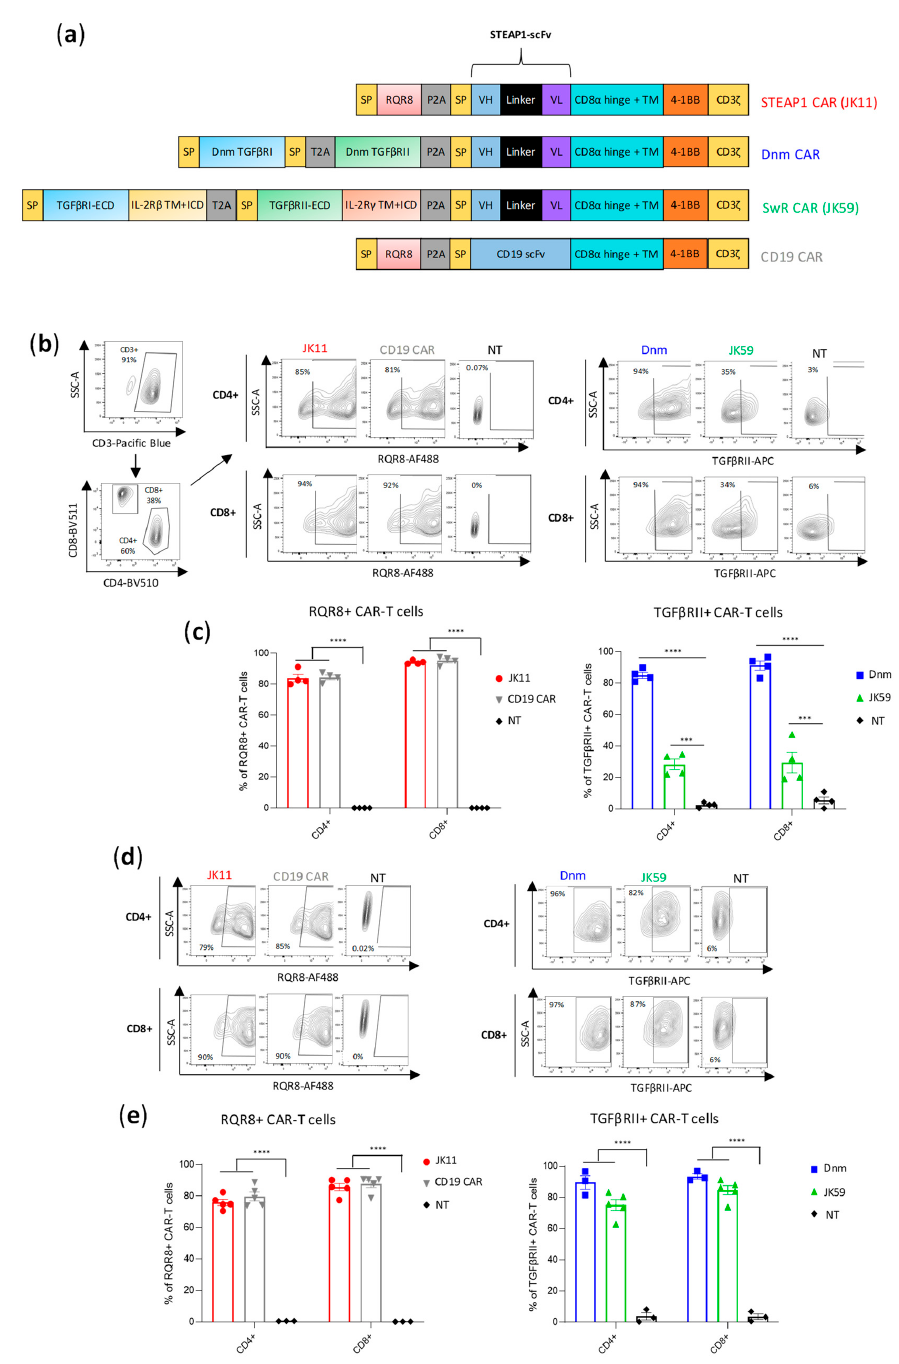
Figure 1. CAR design and expression. ( a ) Schematic representations of the CAR constructs; parental STEAP1 CAR (JK11), control CD19 CAR, dominant negative mutant -STEAP1 CAR (Dnm) with the TGF β receptor (TGF β R) lacking the intracellular signaling domain, TGF β -switch receptor (SwR)- STEAP1 CAR (JK59) with the extracellular domain (ECD) of the TGF β RI and TGF β RII subunits fused to the transmembrane domain (TM) and intracellular domain (ICD) of the IL-2/IL-15 receptor β and γ chains, respectively (IL-2R β and IL-2R γ ). ( b ) Flow analysis of CAR expression in primary human T cells stained with CD3, CD4, and CD8 (left panel), and with the antibody recognizing the RQR8 sequence of JK11 and CD19 control CAR (middle panel) or the TGF β RII antibody recognizing Dnm and JK59 CARs (right panel). T cells were stained five days after viral transduction. ( c ) Graphs representing the expression of JK11 and CD19 CARs (right panel) and Dnm and JK59 CARs (left